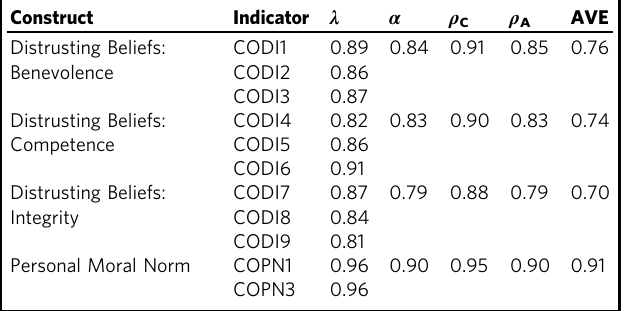
Table 2 Evaluation of the formative measurement model: Convergent validity (path coef fi cient β of redundancy analysis), collinearity (VIF), and indicator weights (original estimate w , bootstrap mean M and t